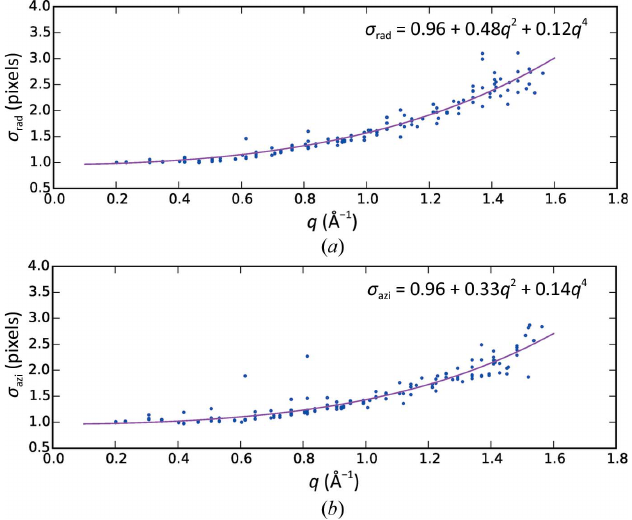
Figure 11 Reflection-peak widths. Widths in ( a ) the radial direction ( (cid:4) rad ) and ( b ) the azimuthal direction ( (cid:4) azi ) of the reflections, shown as a function of the in-plane momentum transfer q . Only the widths of the reflections with an intensity larger than one photon are plotted. The magenta lines represent the biquadratic models indicated in the two panels.